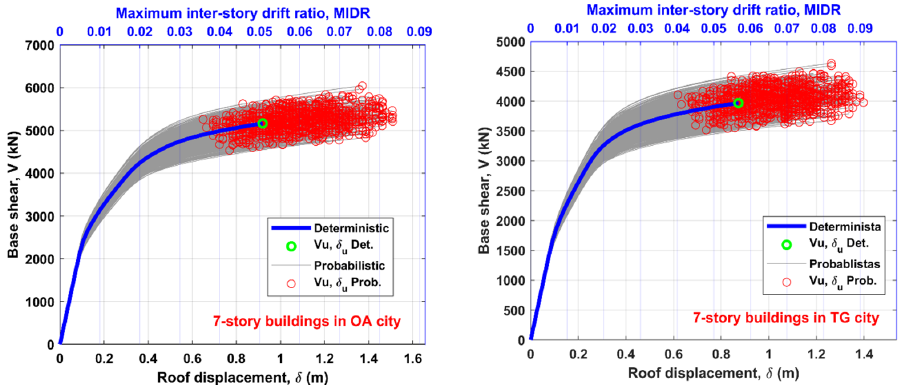
Figure 4. Deterministic and probabilistic capacity curves of the 7-story buildings in OA and TG cities.